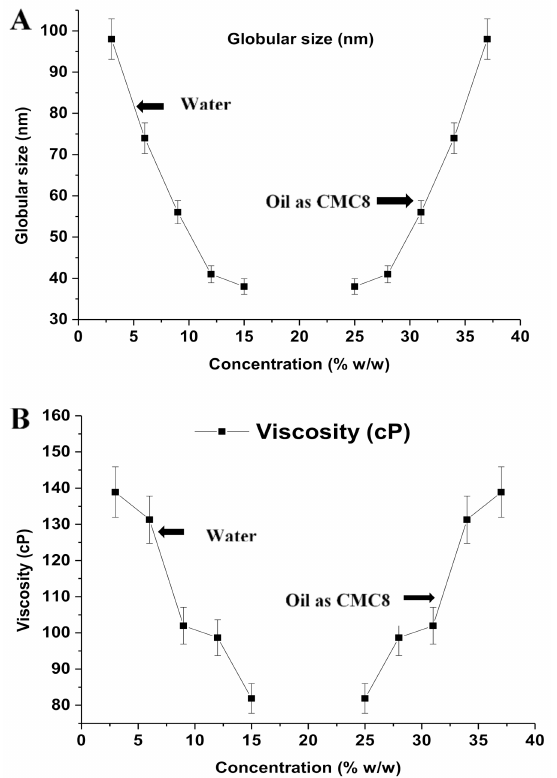
Figure 4. ( A ) The effect of continuous organic phase (CMC8) and internal aqueous phase (water) concentrations on the globular size of water/DMSOT/IPA/CMC8 nanoemulsions, and ( B ) the effect of continuous organic phase (CMC8) and internal aqueous phase (water) concentrations on viscosity (cP) of water/DMSOT/IPA/CMC8